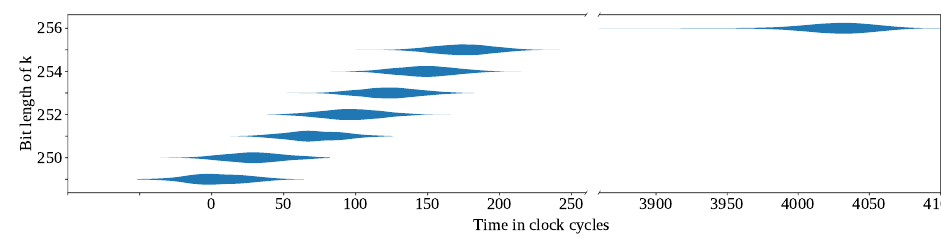
Figure 8: Relative time variation of signature generation depending on length of